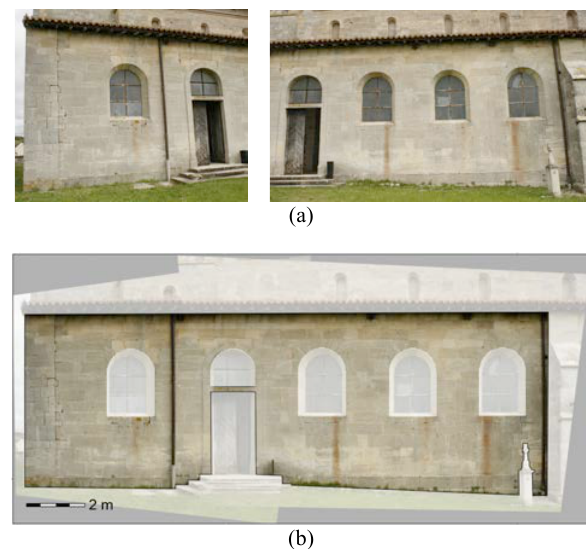
Figure 6. Projective rectification: (a) photographs; (b) mosaic of orthoimages